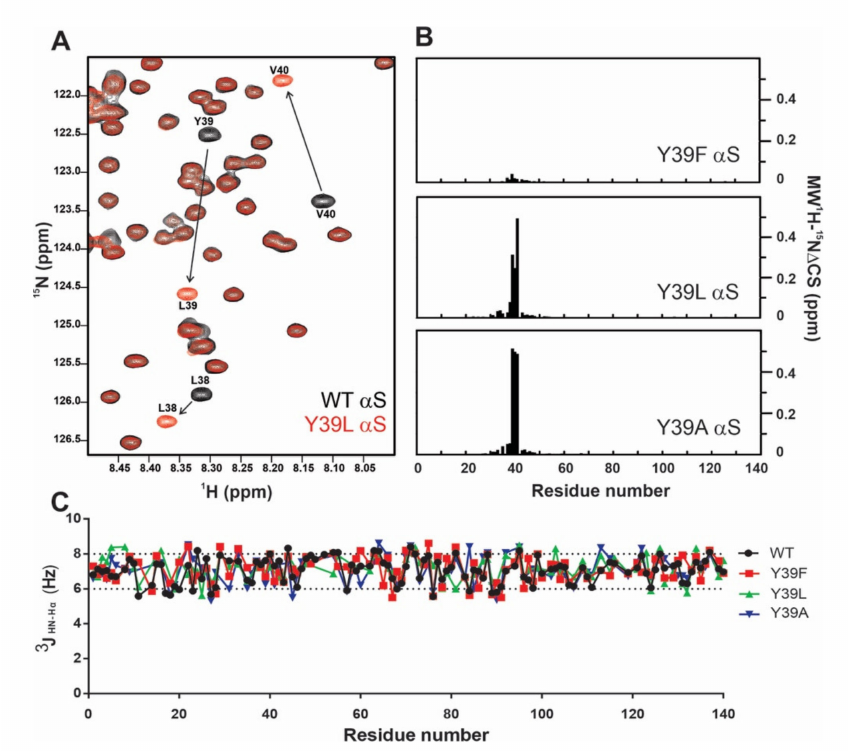
Figure 3. Changes induced by the mutations are only local and restricted to the immediate vicinity of the position-39 residue. ( A ) Overlaid contour plots of 1 H- 15 N heteronuclear single quantum correlation (HSQC) spectra of 50 µ M wt (black) and Y39L α S (red). Most a ff ected residues located in the vicinity of the mutated site are labeled. ( B ) Di ff erences in the mean weighted chemical shifts (MW 1 H- 15 N ∆